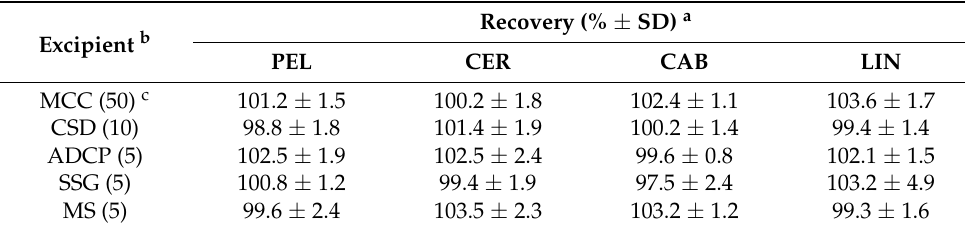
Table 8. Analysis of TKIs in the presence of the excipients are those present in their solid pharmaceu- tical tablets by the proposed MW-SPA based on their CT reactions with